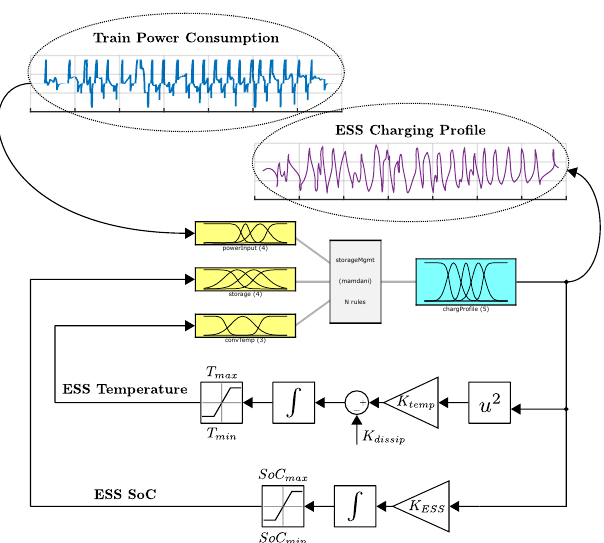
Figure 7. Detail on the calculation of the ESS Temperature and ESS SoC.